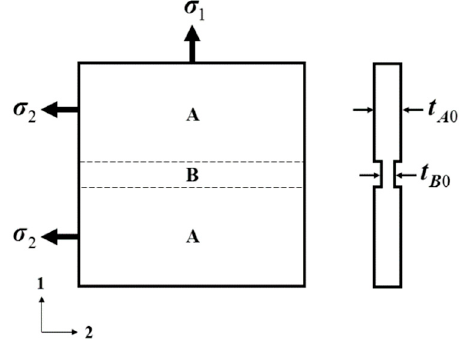
Figure 10. Assumption of initial imperfection in M-K theory.